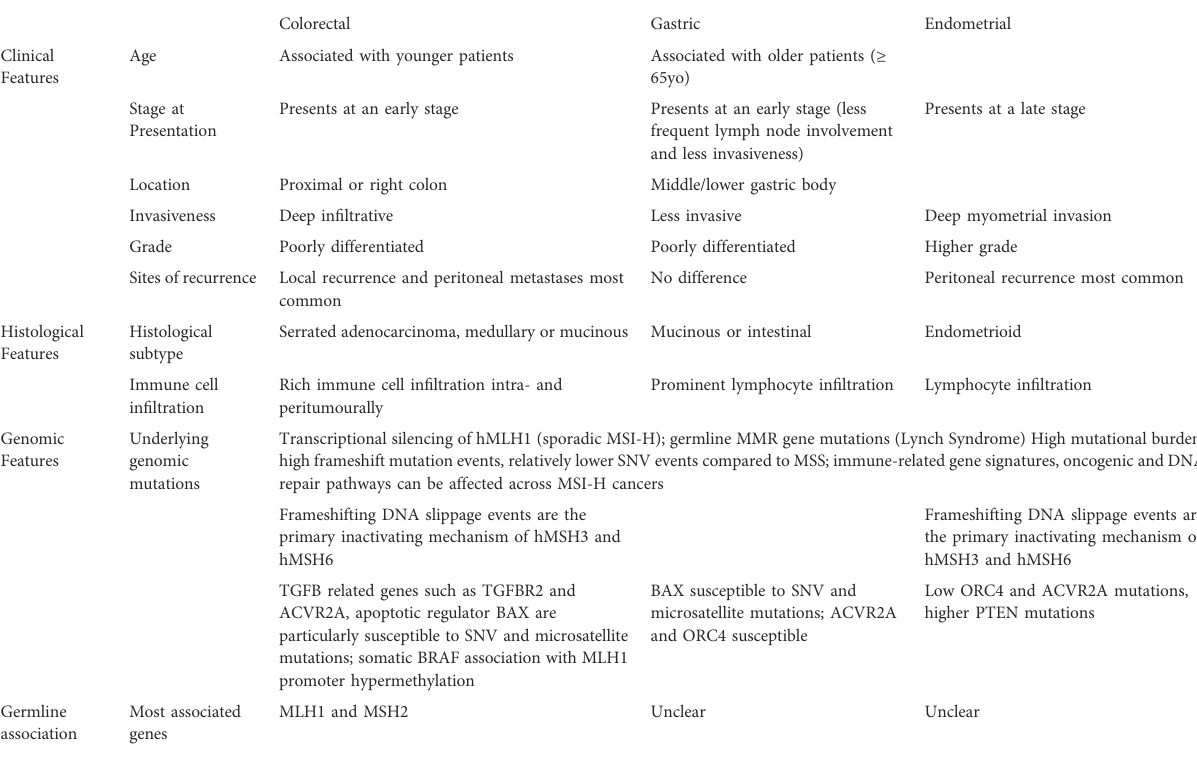
TABLE 1 Comparing clinical, histologic and genomic features of MSI-H colorectal, gastric, and endometrial cancers. Comparing MSI-H colorectal, gastric, and endometrial